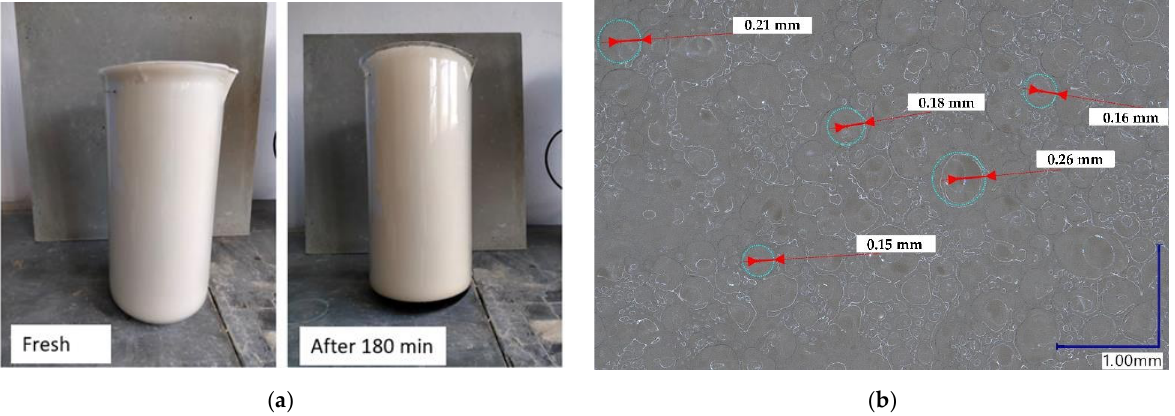
Figure 4. ( a ) The produced protein-based foam and ( b ) the structure of the foam with a density of 70 kg/m 3 .